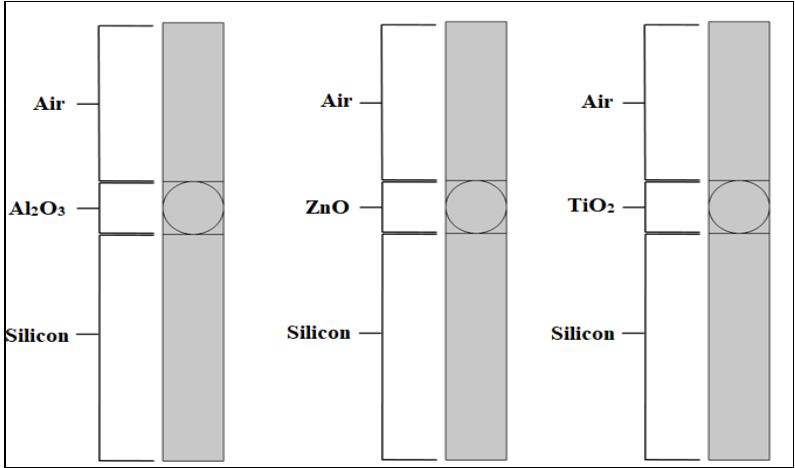
Figure 1. A schematic diagram showing the Al 2 O 3 , TiO 2 , and ZnO nanoparticle 2D model placed on top of a Si